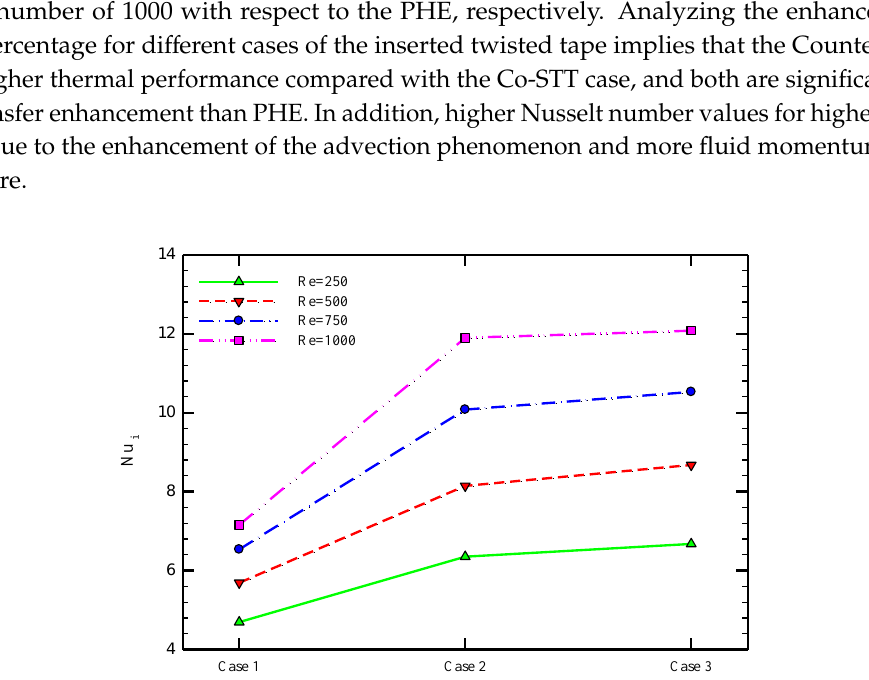
Figure 6. Local bulk temperature distribution along the length of the tube for PHE, Co-STT and Counter-STT at Reynolds number of 250.